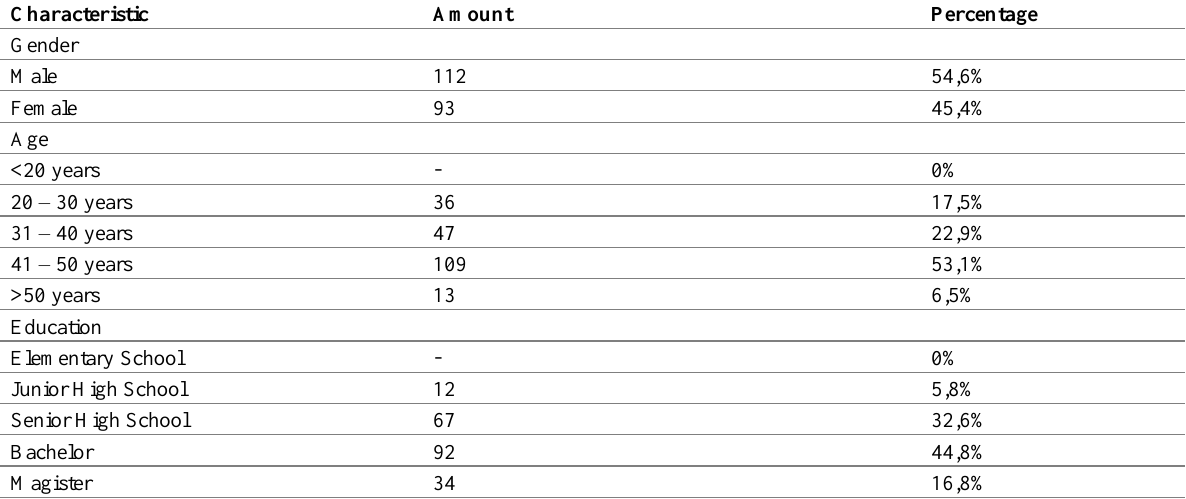
Table 1: Respondents’